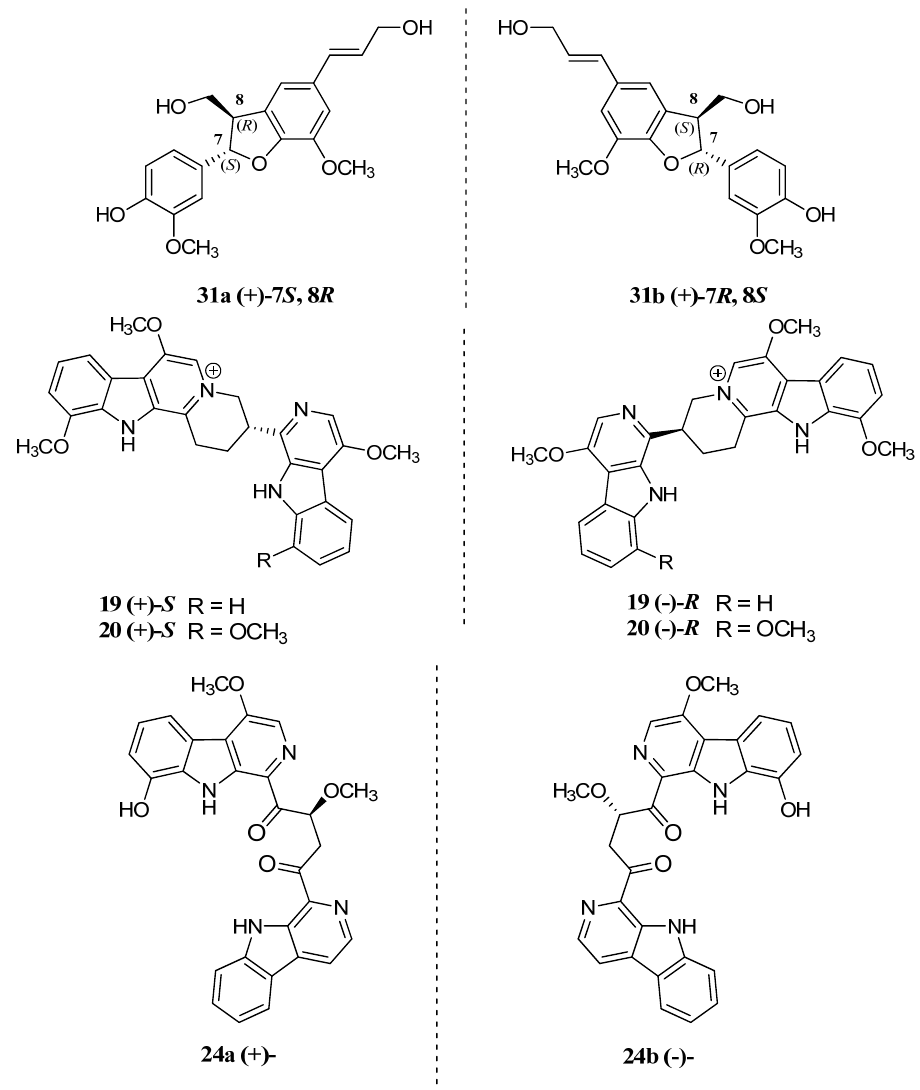
Figure 3. The stereoisomerity of dehydrodiconiferyl alcohol ( 31 ), quassidine I ( 19 ) and J ( 20 ) and kumudine B ( 24 ) (from left to right) responsible for the enhanced anti ‐ cancer property of Picrasma quassioides [19,21,26].